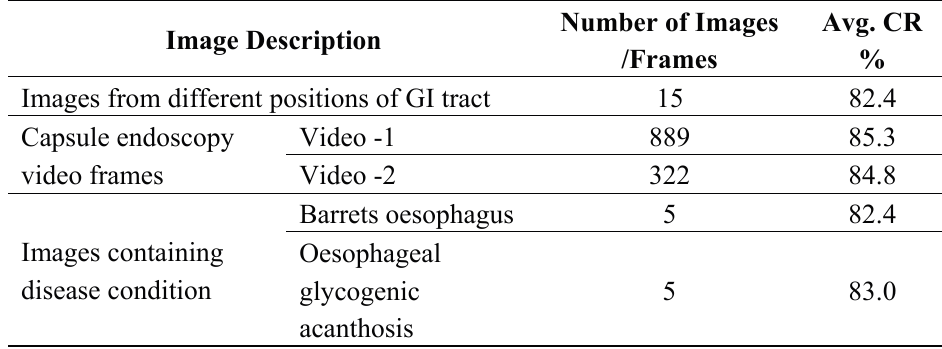
Table 5. Compression ratio of the proposed algorithm for NBI images.